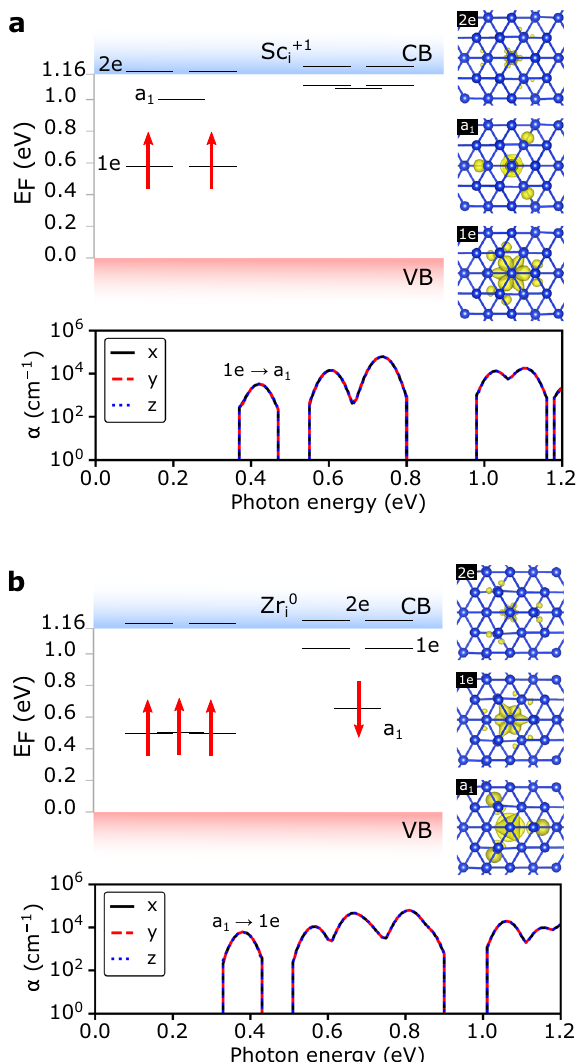
Fig. 5 Single-particle defect-level diagram and absorption spectra for representative interstitial defects of transition metals. Both a Sc þ 1 and b Zr 0 have the C 3 v symmetry. Numbers are used to i i distinguish different defect states while letters highlight their symmetries. The isosurface plots of the charge density of corresponding defect states are shown at the density of 0.0025 1 a 3 B and along the principle axis of the C 3 rotation, i.e., <111>. Absorption coef fi cient ( α ) are provided, with speci fi c peaks indicated for the corresponding transitions between labeled defect states within the band gap. x, y, and z indicate the polarization direction. and V þ 1 ), which also All the other interstitial defect candidates (Zr þ 2 i i have in-gap triplet – triplet optical transitions, can be found in the Supplementary Fig.